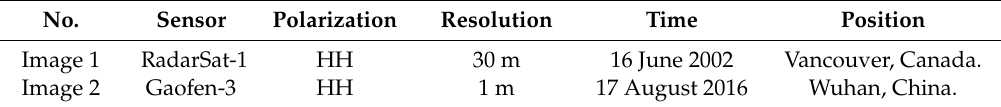
Table 5. Detailed descriptions of two SAR images from RadarSat-1 and Gaofen-3.